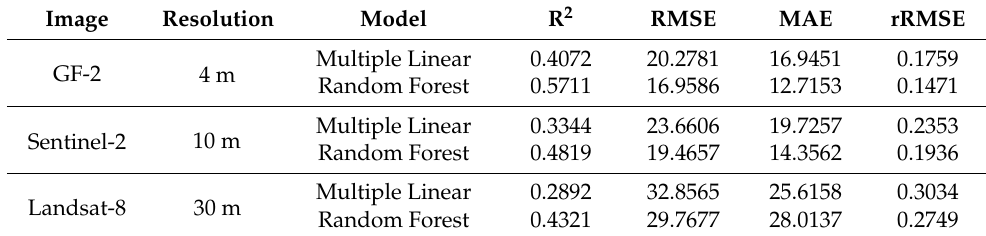
Table 4. The comparison of the AGB prediction accuracy with various remote sensing data.